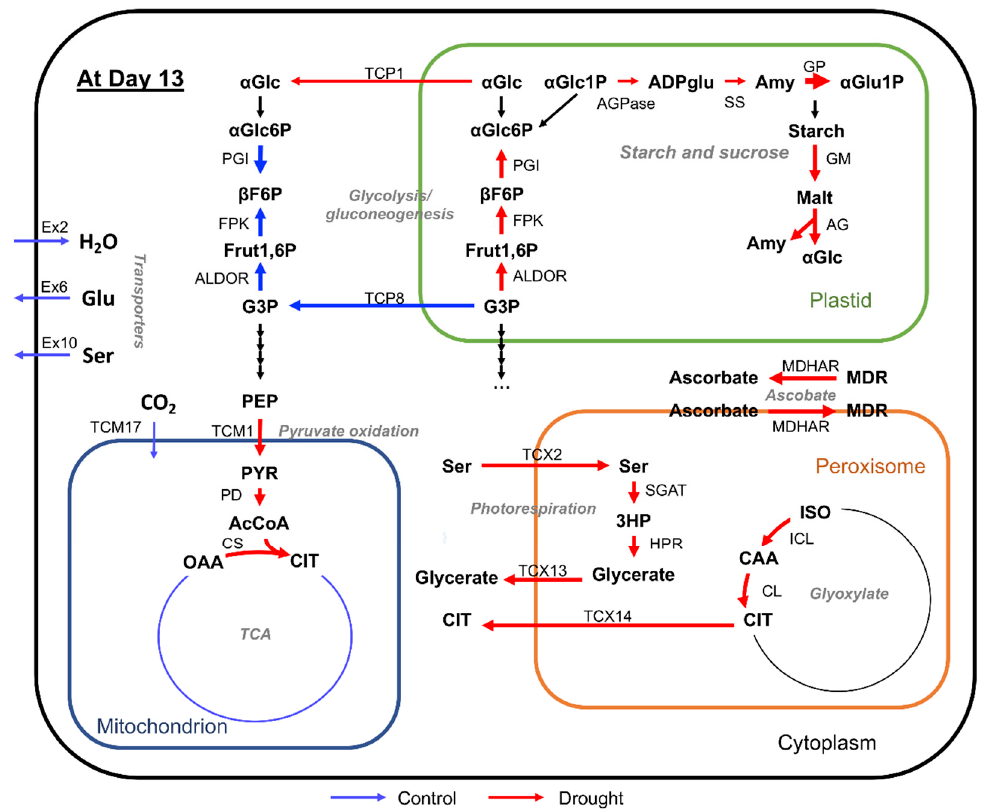
Figure 8. Metabolic pathway showing the reactions involved in drought stress response at day 13: Red and blue arrows represent active reactions in drought and control, respectively. The thickness of arrows represents fold-change values. Metabolites: α Glc, alpha-D-glucose; α Glc6P, alpha-D-glucose 6-phosphate; β F6P, beta-D-fructose 6-phosphate; Fruc1,6P, fructose